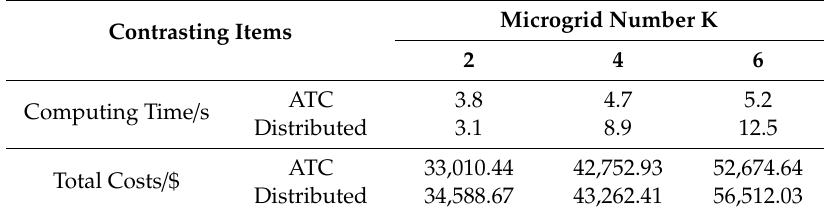
Table 5. Analysis of advantages and disadvantages between the ATC and distributed methods.